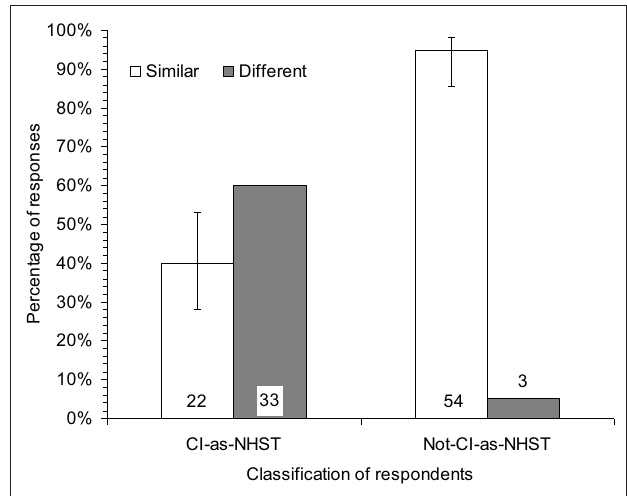
Figure 7 | Percentages of text responses in experiment 1 classified as indicating the two studies gave Similar or Different results, for respondents classified as referring to NHST (Ci-as-NHST), or not referring to NHST (Not-Ci-as-NHST), when interpreting Ci results. Numbers of respondents are shown at the bottom. Results are combined for all three disciplines and the two CI formats. For each group of respondents, the Similar and Different percentages sum to 100, so 95% CIs are shown for only one